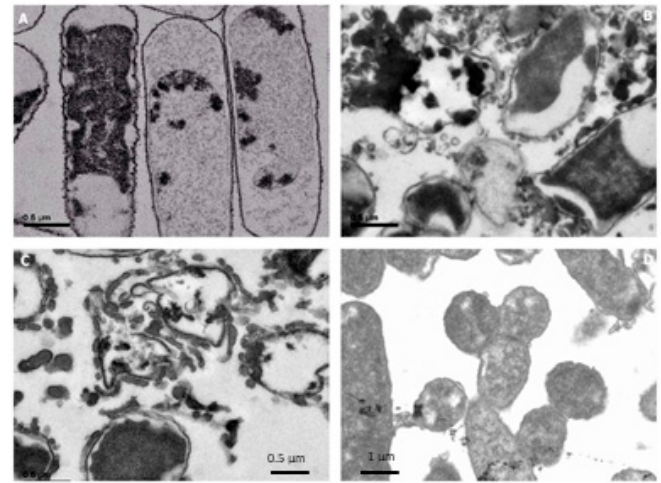
Figure 8. Electron microscopy micrographs (40×) analysis of Escherichia coli nonincubated and incubated with modified hen egg white lysozyme (HEWL) for 15 h at concentration of 0.5 mg/mL. ( A ) Bacteria control without HEWL, ( B ) HEWL/90 °C at pH 6.0, ( C ) HEWL/120 °C at pH 6.0, and ( D ) HEWL/DTT 2.0 h.